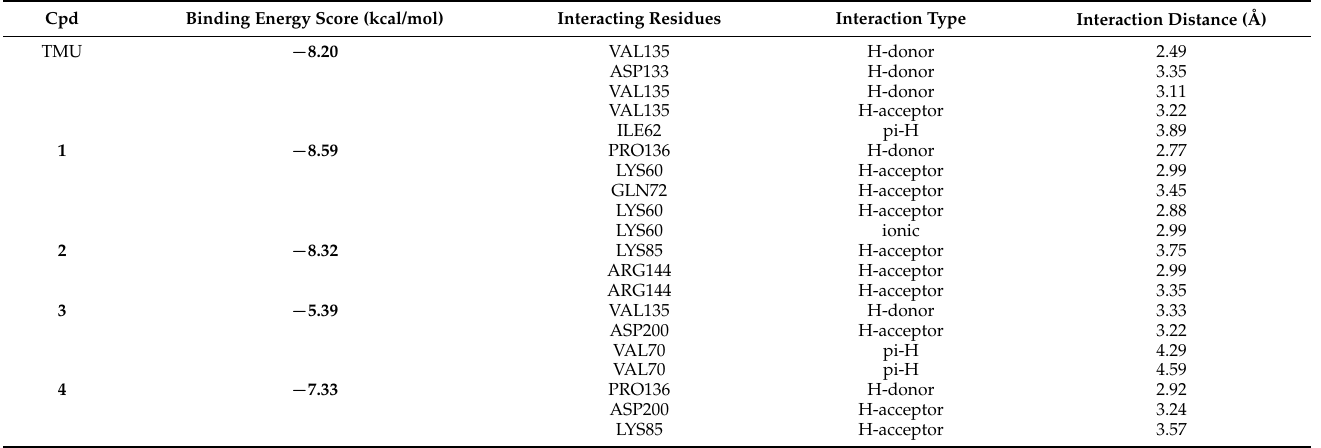
Table 7. The molecular docking results of compounds 1 – 21 using PDB 1Q5K for GSK3 enzyme. Cpd Binding Energy Score